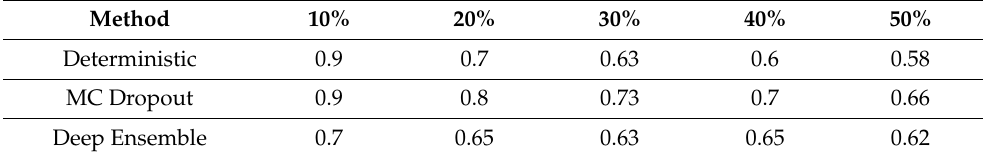
Table 4. Percentage of OOD image chips that get thresholded for quality assessment, out of the total number of image chips that gets thresholded at each data retention tier, i.e. if number is higher, the method includes more OOD image chips in the total batch sent for human